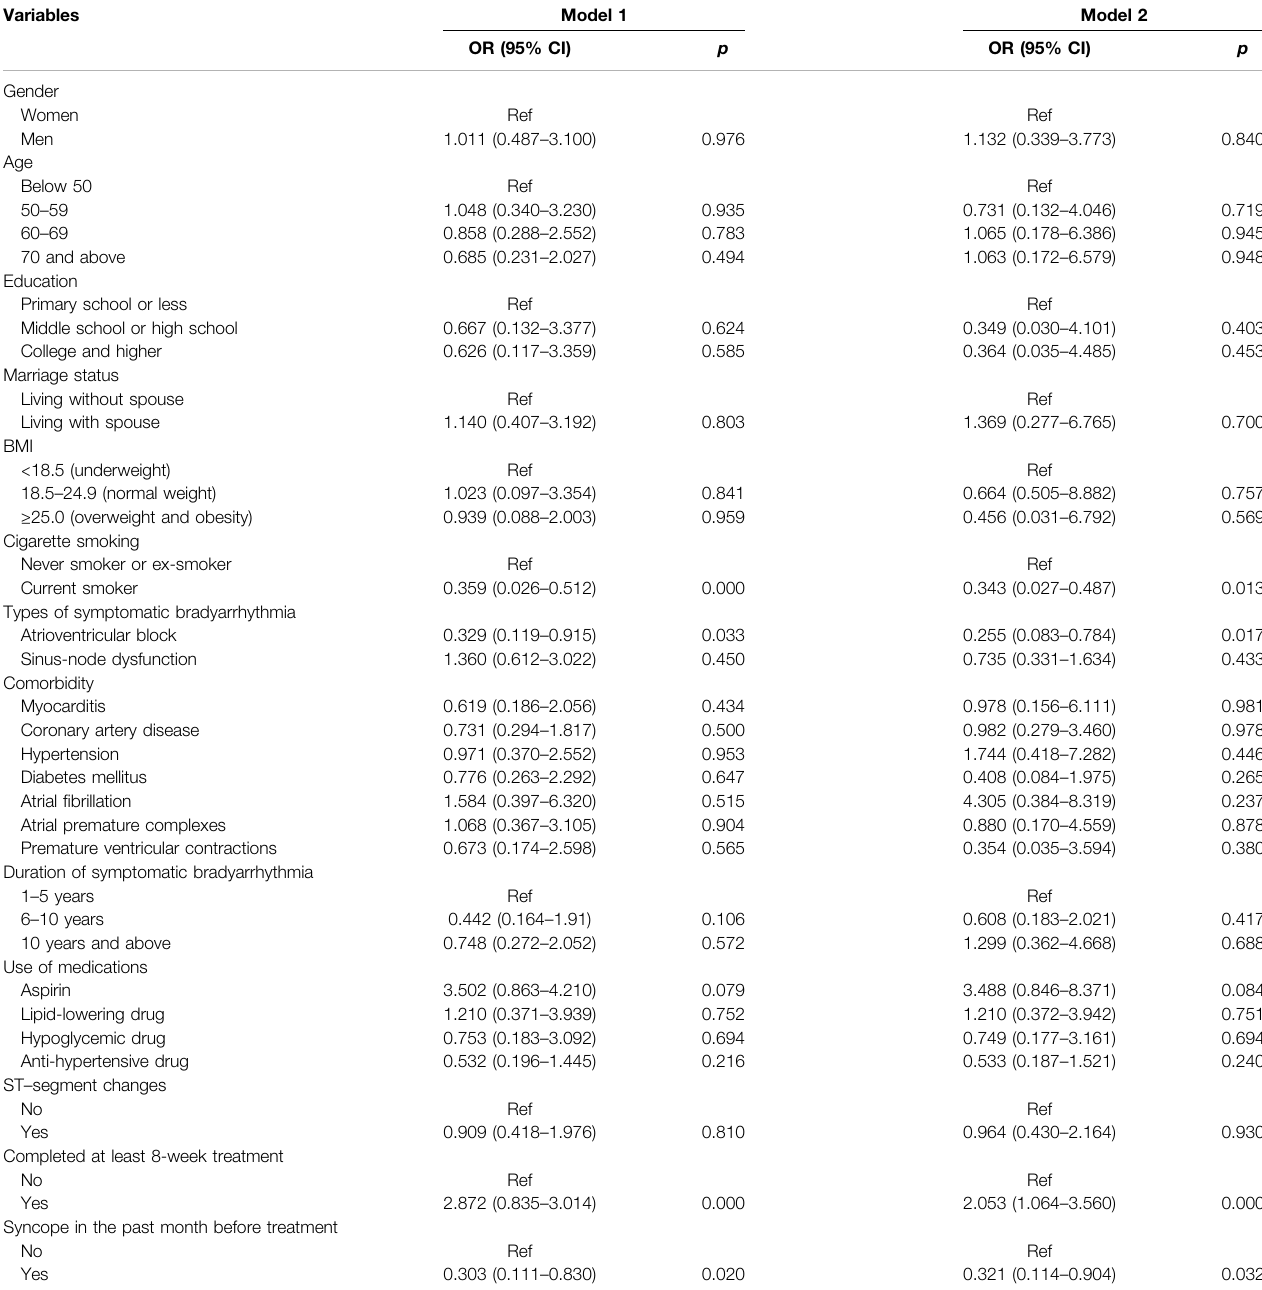
TABLE 2 | The Adjusted ORs for favorable treatment outcome at 16